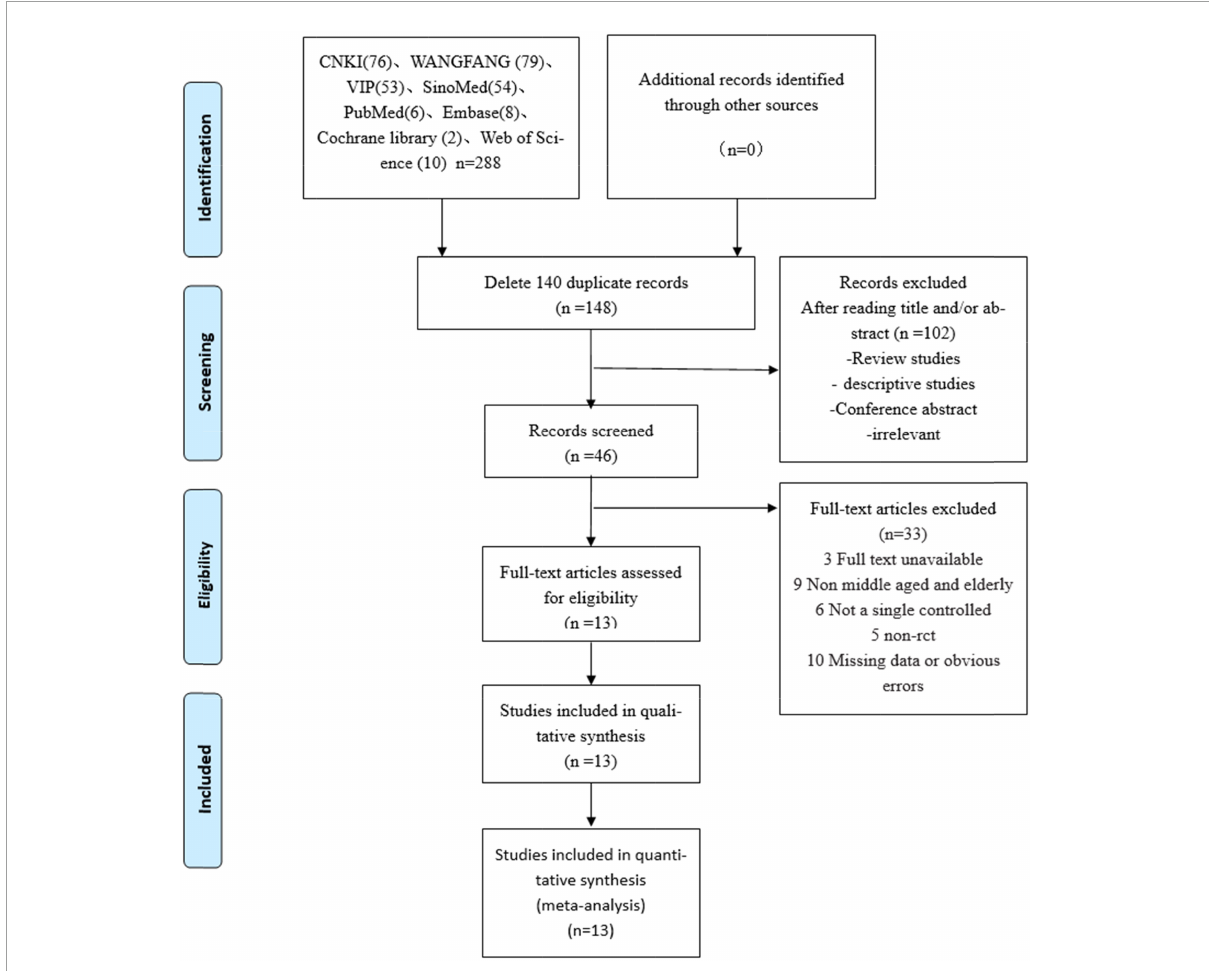
FIGURE1 Flowchart of the study search and selection